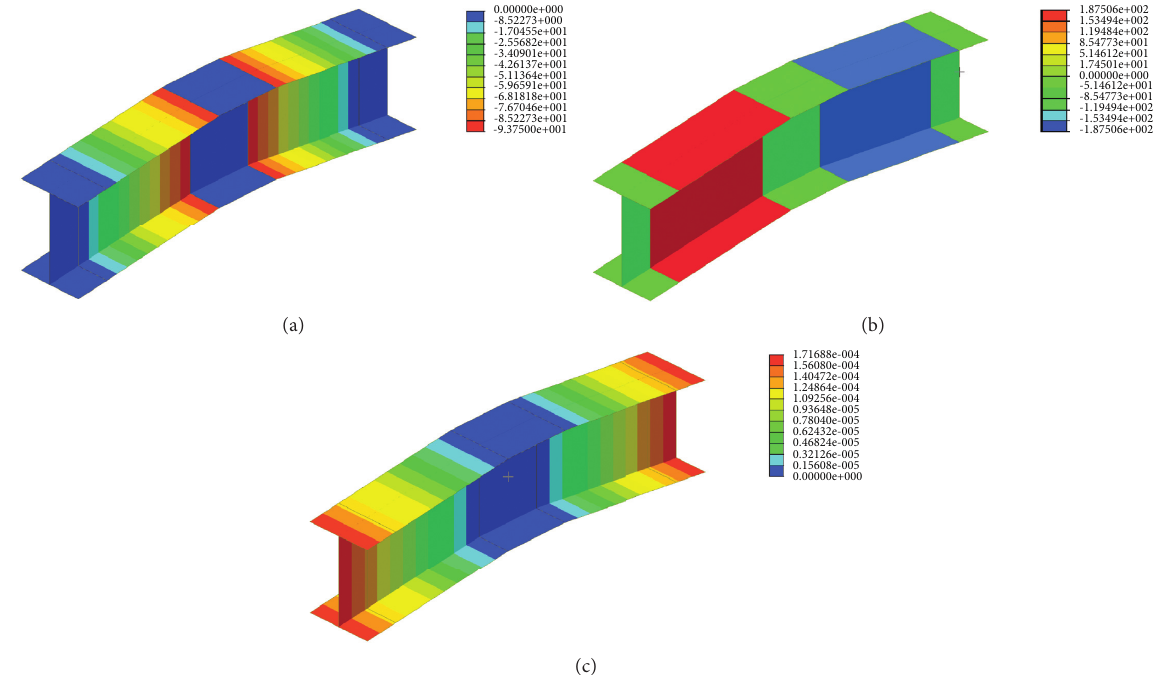
Figure 11: State of the lower reaction beam: (a) bending moment diagram of the lower reaction beam; (b) shear diagram of the lower reaction beam; (c) displacement diagram of the lower reaction beam.